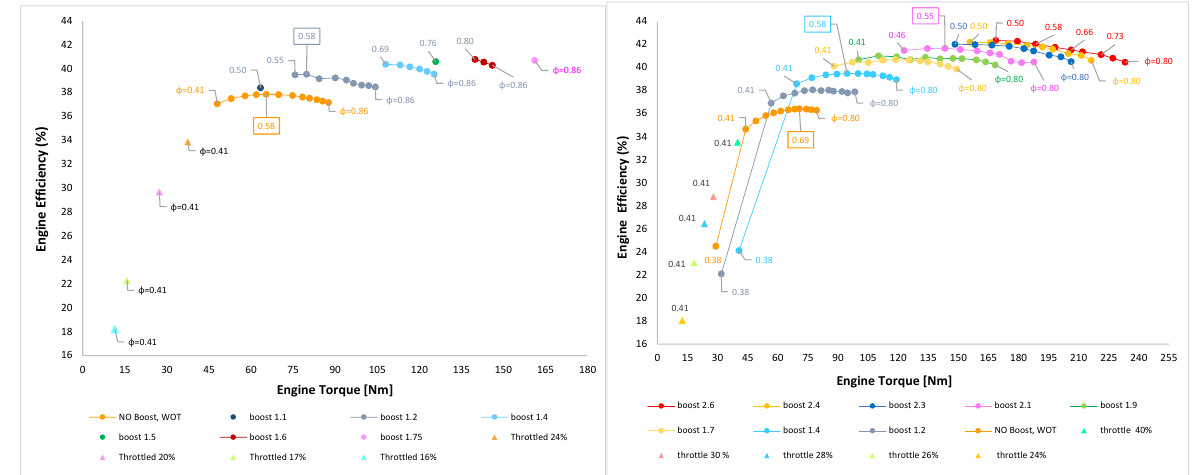
8 of 13 Figure 4. Exhaust Gas temperature, in-cylinder pressure peak and knock intensity versus spark angle. ( Left ): boost = 2.6 bar, ϕ = 0.5; ( middle ): boost = 2.3 bar. Φ = 0.8; ( right ): boost = 2.6 bar, ϕ = 0.8. Engine running at 3000 rpm. Naturally, at a given equivalence ratio, the boost pressure and the torque output can be lowered by increasing the wastegate valve opening. When the wastegate valve is fully opened (i.e., the engine is not supercharged), the delivered torque can be further lowered by throttling the engine. In this way, the engine load can be regulated by ap- propriately combining the mixture richness, the boost pressure, and the throttle opening. For all the investigated points, Figure 5 portrays the engine efficiency as a function of the delivered torque. When the air – fuel equivalence ratio is less than 0.4, the mixture becomes too diluted. At 1500 rpm the mixture does not burn at all, while at 3000 rpm, the combustion slows down excessively, penalizing the engine efficiency. Consequently,